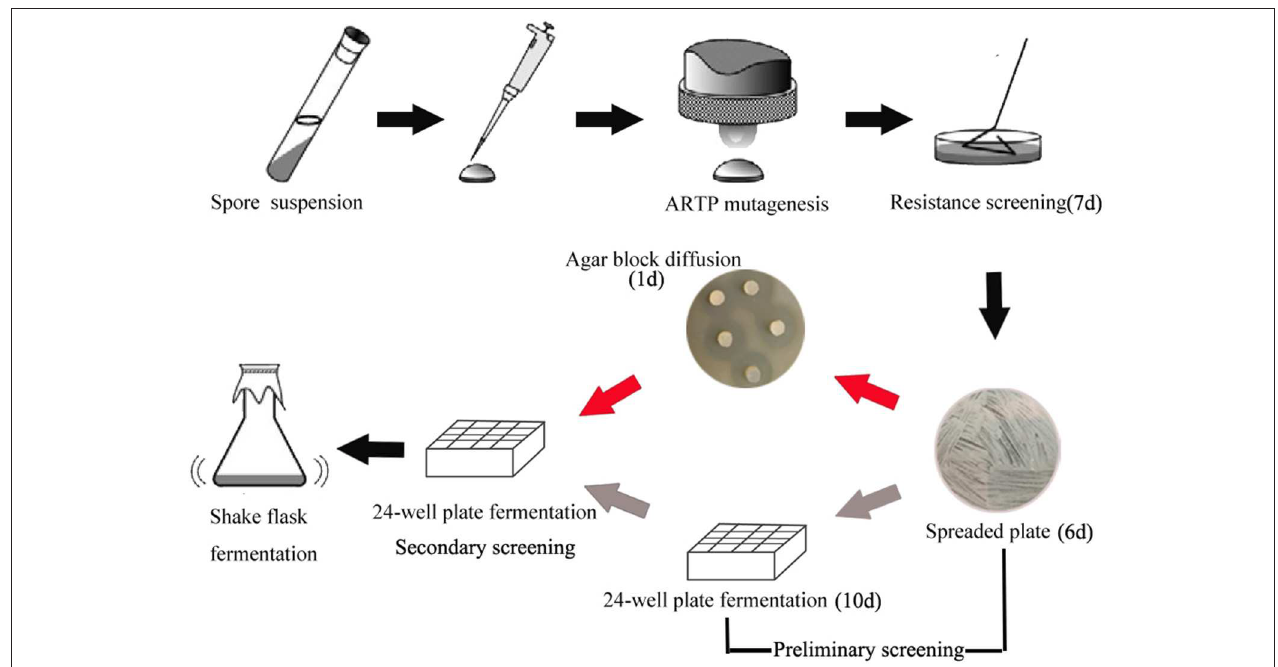
FIGURE 2 | Optimized breeding method screening procedure. The gray arrow in preliminary represent the original breeding process, the red arrow in preliminary represent the developed breeding process.